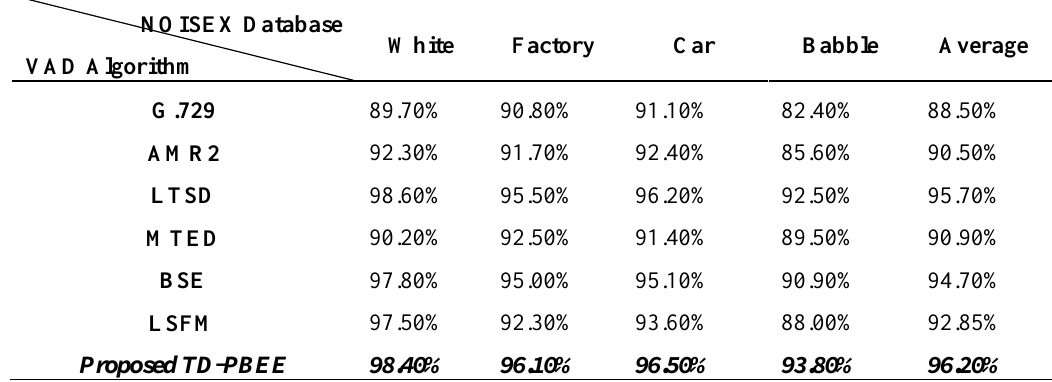
Table 3. Speech hit rate (HR1) from clean to 5 dB under the four types of